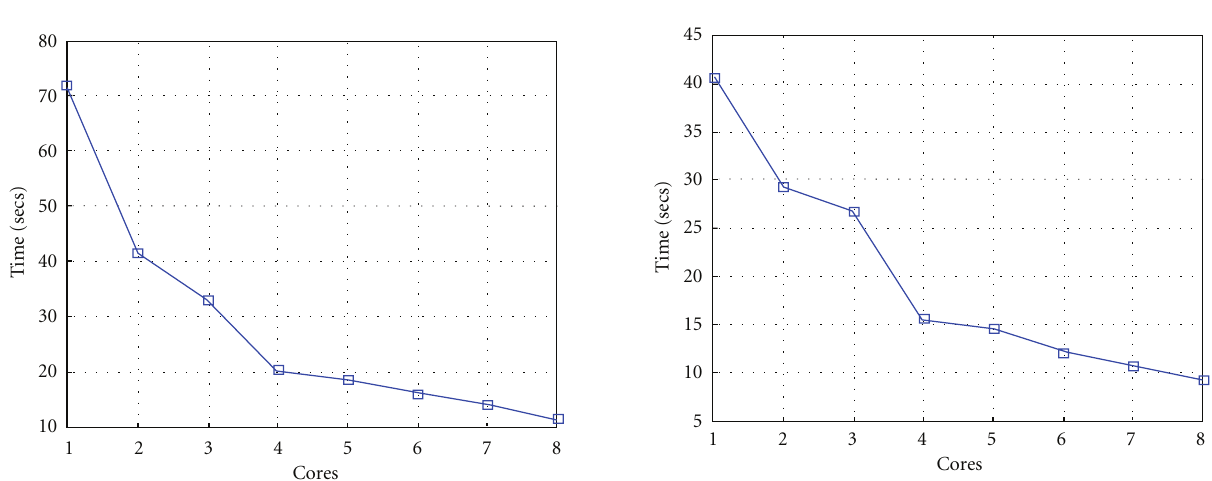
Figure 17: Test 1: Algorithm I: E ffi ciency. Δ τ I = 0 . 4.